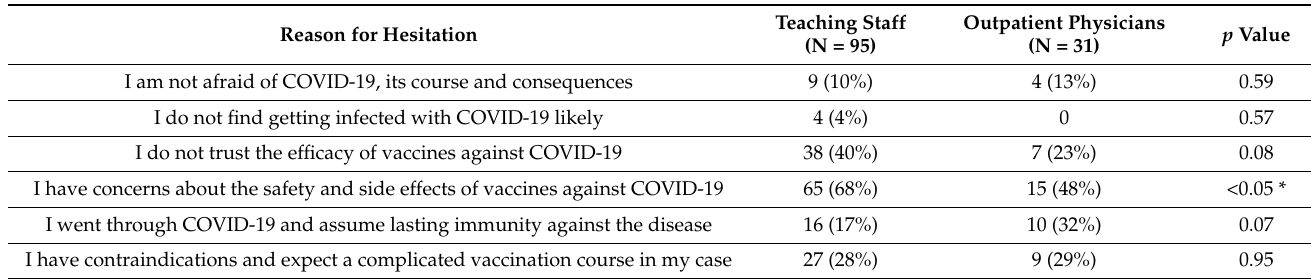
Table 5. Reasons for hesitating to get vaccinated against COVID-19 (N = 126).